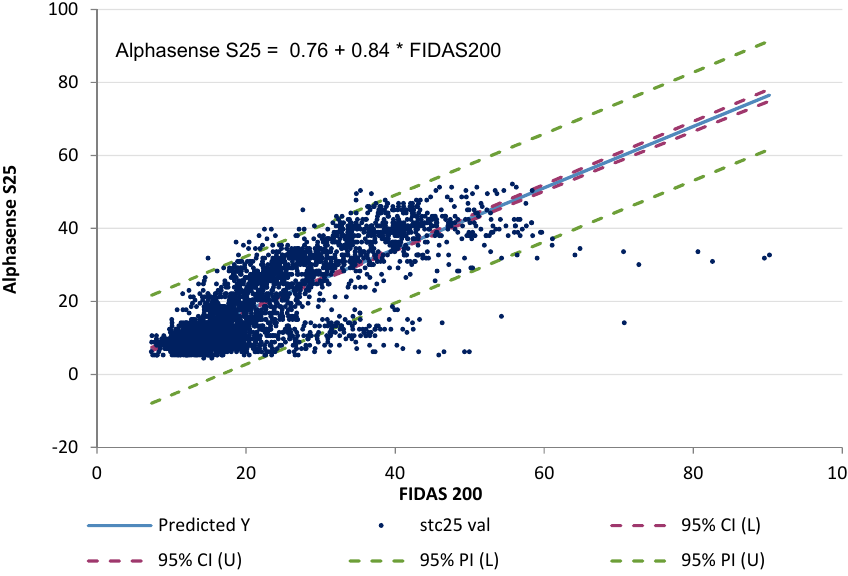
Figure 5. Linear regression plot of reference measurement results (FIDAS 200). Measured and predicted sensory values according to regression equation are presented in the plot.